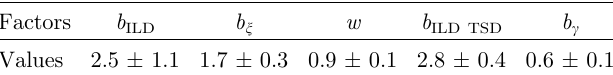
Table 3. Mean weighting factors with ±95% CIs for different acoustic cues.